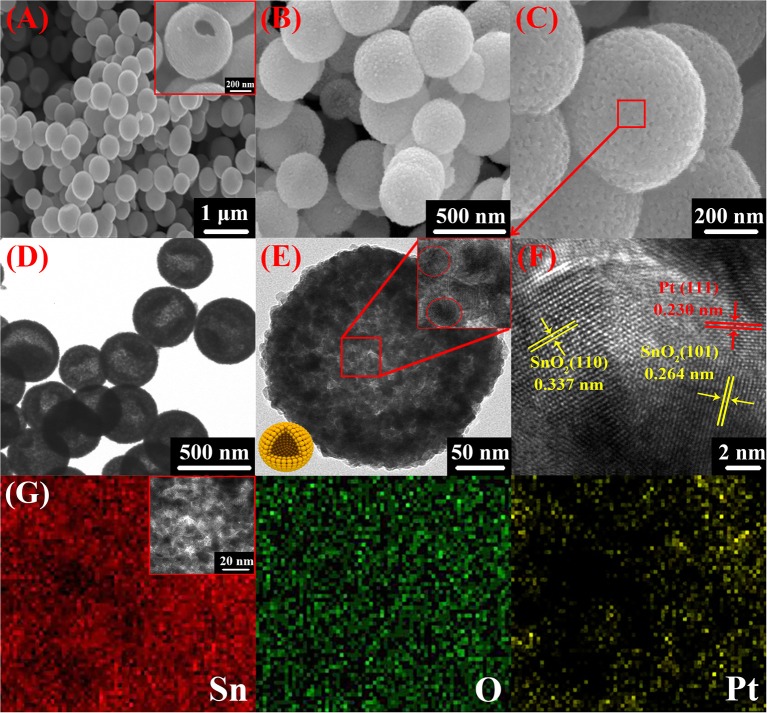
SEM (A–C), TEM (D), and HRTEM (E,F) of 0.16 wt% Pt doped SnO2 mesoporous hollow nanospheres; (G) elemental mappings of 0.16 wt% Pt doped SnO2 mesoporous hollow nanospheres for Sn, O, and Pt.